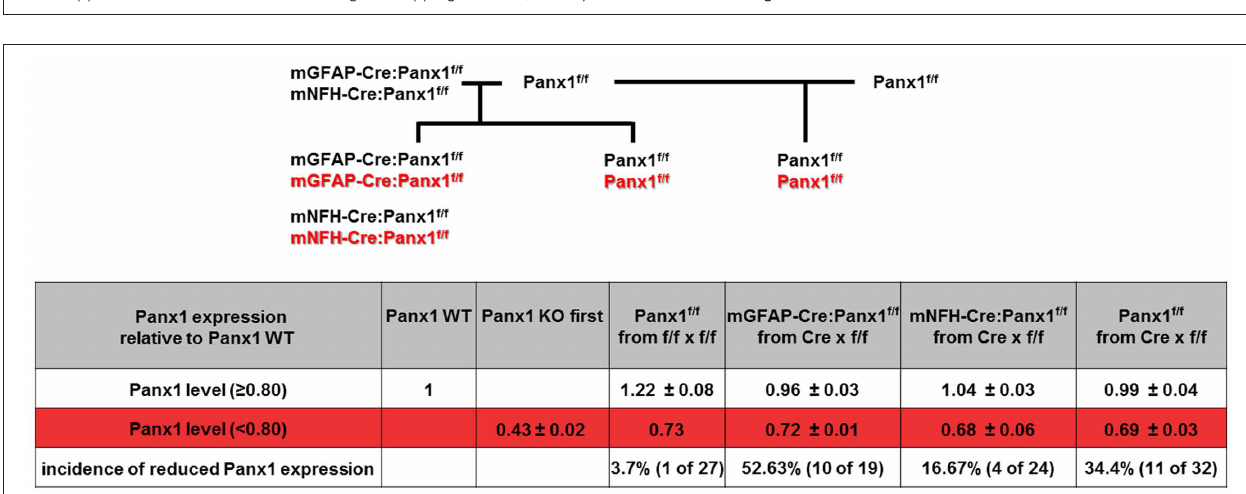
FIGURE 4 | Schematic view of the generation of conditional GFAP-Cre and NFH-Cre Panx1 tm1a ( KOMP ) Wtsi mice. Mice homozygousfor the “knockout-first” allele are expected to have a null phenotype due to the splicing of exon 1 to a lacZ trapping element and disruption of Panx1 mRNA expression. The insertion cassette is flanked by FRT recombination sites that allow flippase recombinase to remove the gene-trapping cassette, hereby